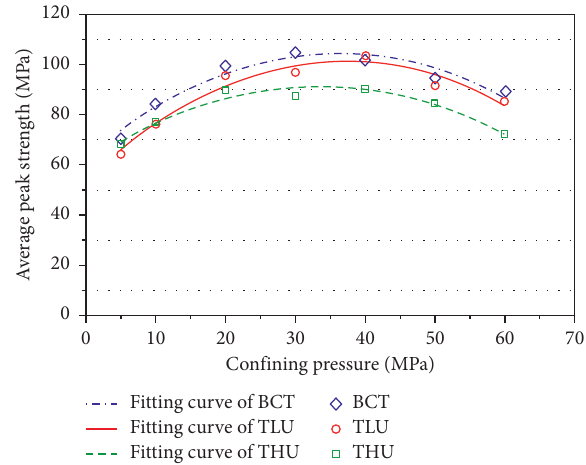
Figure 7: Relationship between the average peak strength and unloading